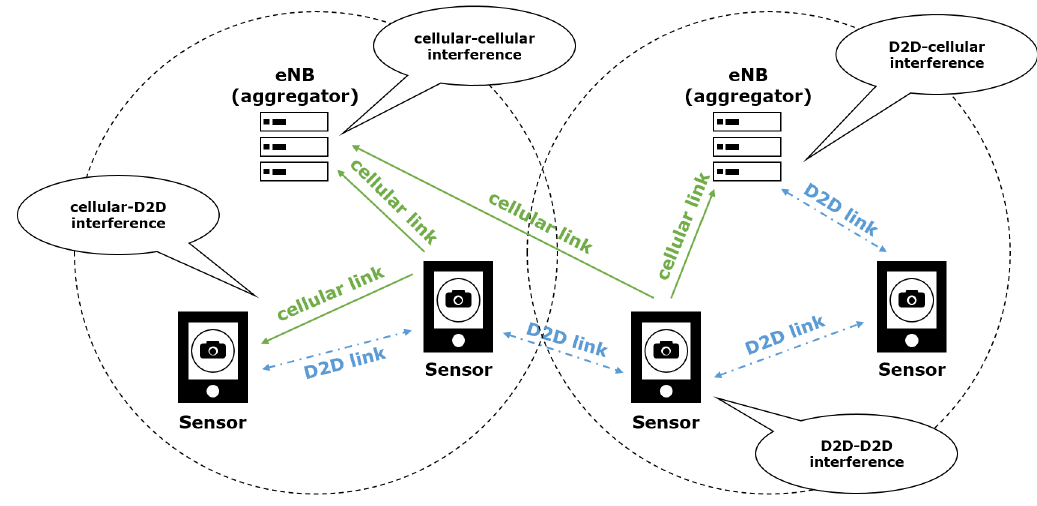
Figure 2. The case of interference in D2D